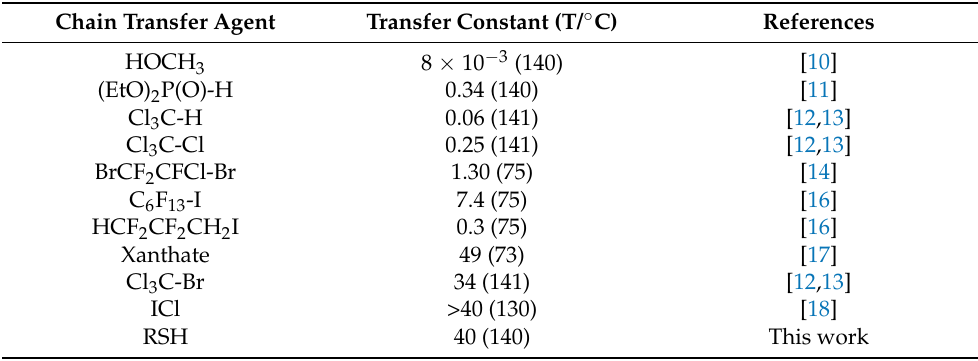
Table 1. Summary of radical telomerisations of VDF with various chain transfer agents and their transfer constants.